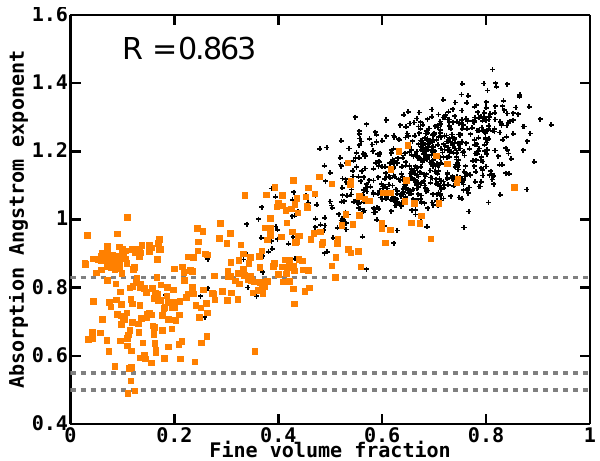
Figure 6. AAE(440–870) vs. fvf at all AERONET sites of Table 1, filtered for a maximum spectral variability in k(λ) of 10% with respect to the mean retrieved k . Orange squares are dust sites and black “ + ” symbols are biomass burning sites. Dashed lines denote the AAE sC postulated by Chung et al. (2012b) and Bahadur et al.